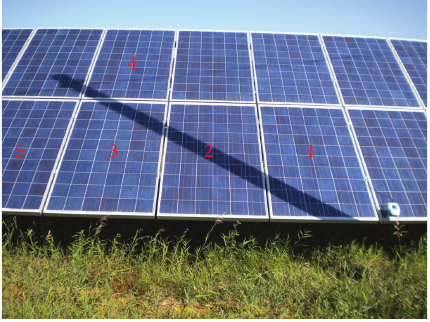
Figure 4: The numbers of the PV modules shaded by wire